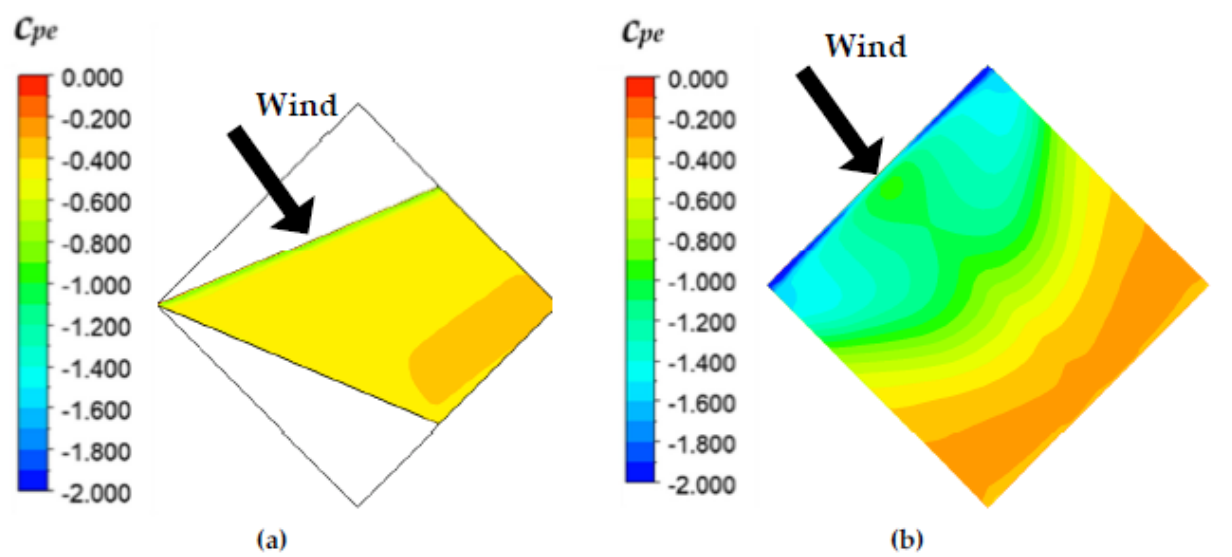
Figure 12. The mean values of c pe on the top (wind direction 45°). ( a ) Atypical structure; ( b ) the cuboid.